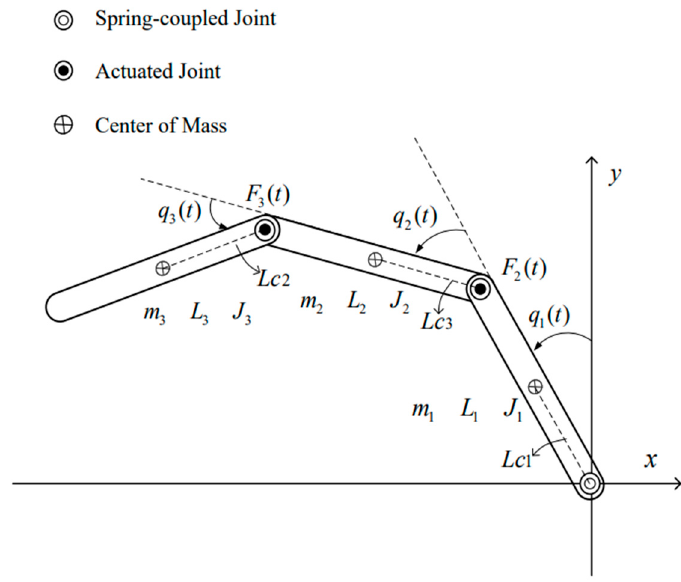
Figure 1. Spring-coupled three-link horizontal manipulator (STHM).